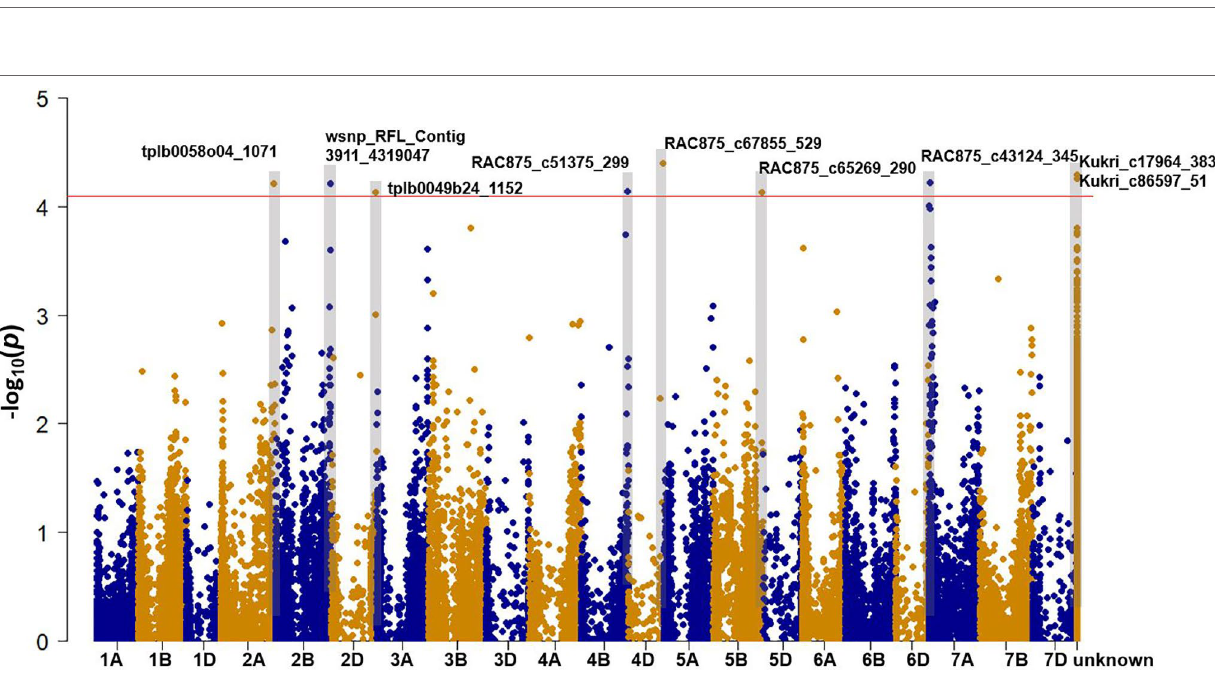
FIGURE 2 | Manhattan plot showing the association signals for leaf Na + concentration using 100 bread wheat entries grown under sodicity (8 g kg -1 Na + -humate) in Experiment 1 (n = 4). The x-axis indicates the physical location of SNP markers along each wheat chromosome; the y-axis shows the P -value of SNP markers for the association test on a log scale. The horizontal red line indicates the significance threshold (P-value = 8.91e-5). The marker names of SNPs above the threshold are